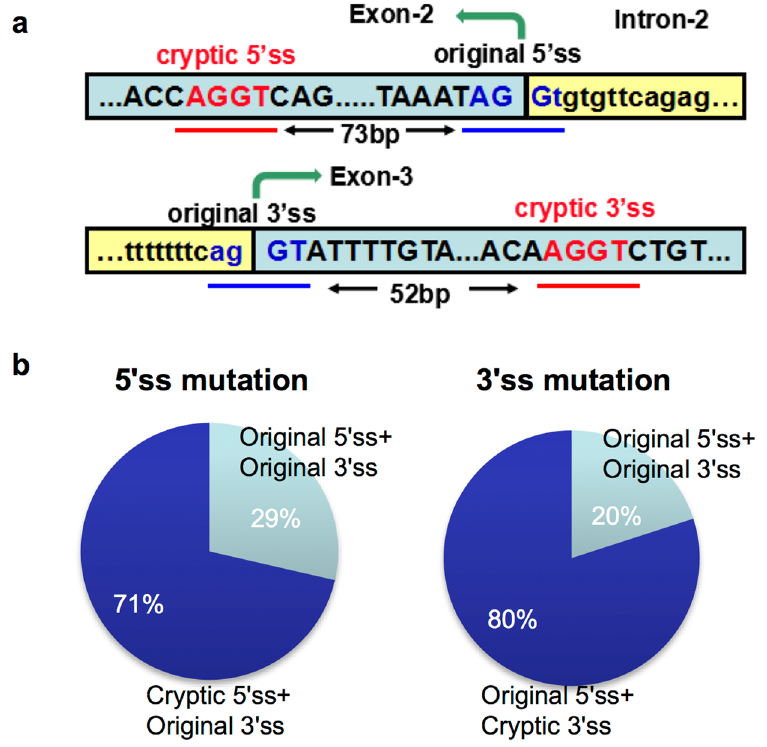
Figure 6. Cryptic splice sites and splicing pattern detected in oxt6 mutant transgenic lines. ( a ) Cryptic 5 ′ and 3 ′ splice sites of Intron-2 in OXT6 gene detected in transgenic lines with splice site mutations. Original splice sites are indicated in blue while cryptic splice sites are indicated in red. Original exons 2 and 3 are marked by green arrows. ( b ) Splicing pattern detected in transgenic lines with splice site mutations. N = 7 for clones with